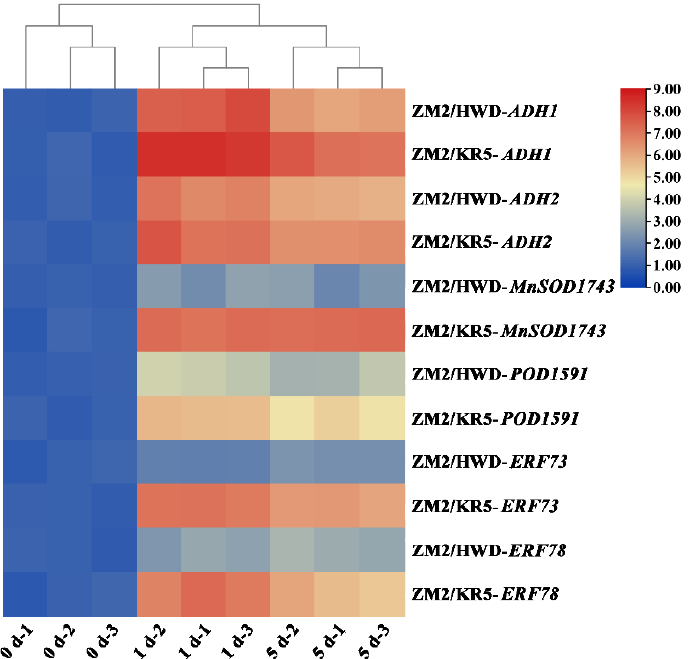
Figure 5. Expression profiles of waterlogging stress-related genes in the roots of scion–rootstock combinations. Blue color indicates a low expression level, whereas red color indicates a high expression level. Heat map was created using Tbtools.